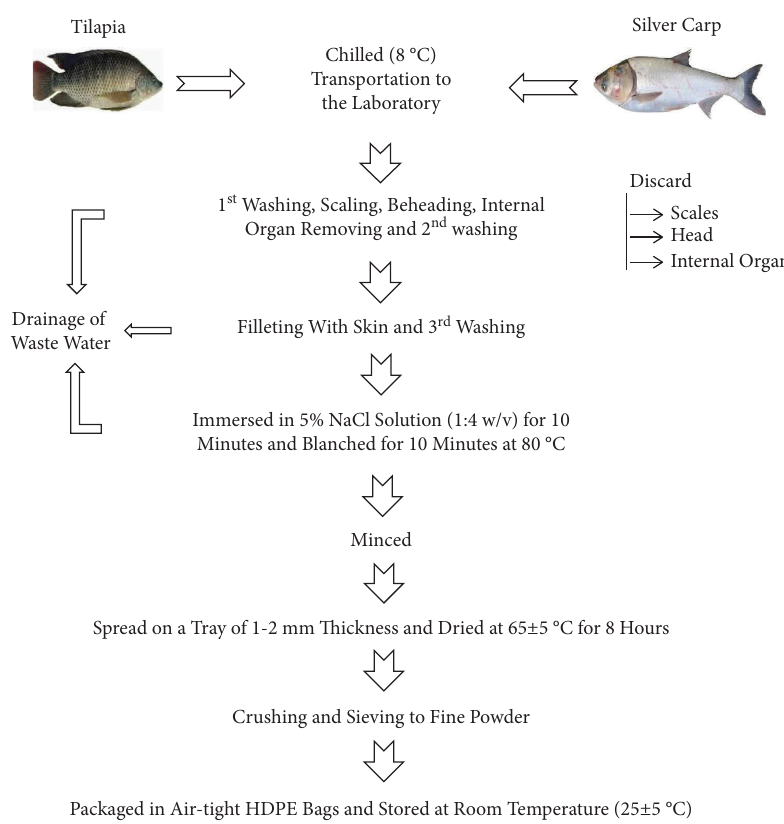
Figure 2: Flow chart of fsh powder